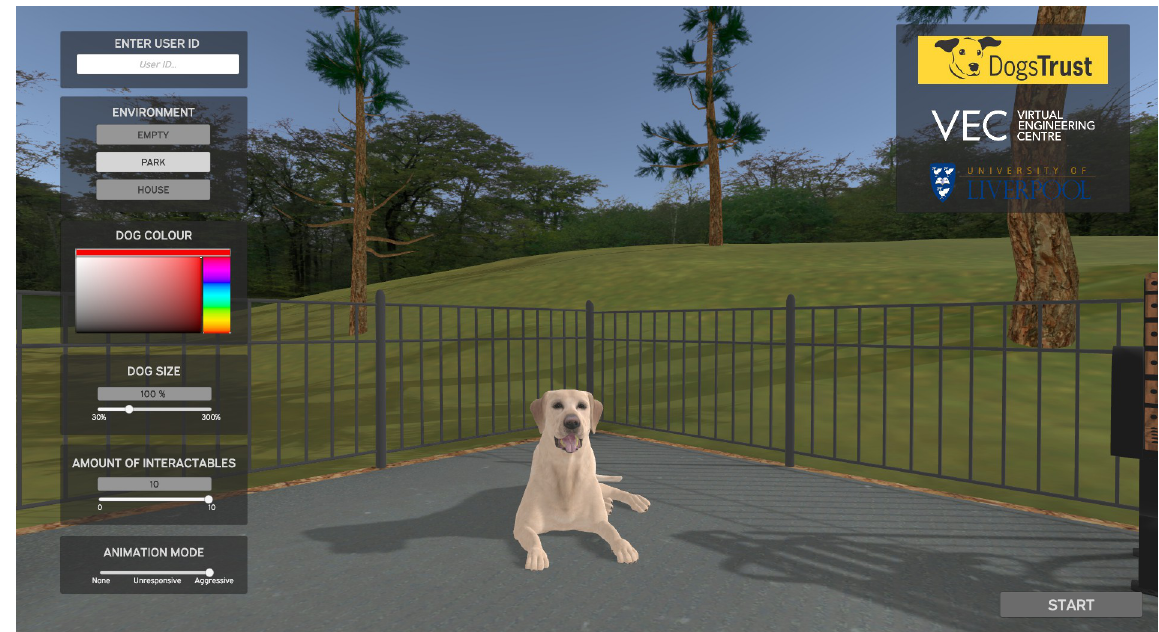
Fig 1. The main menu of the DAVE